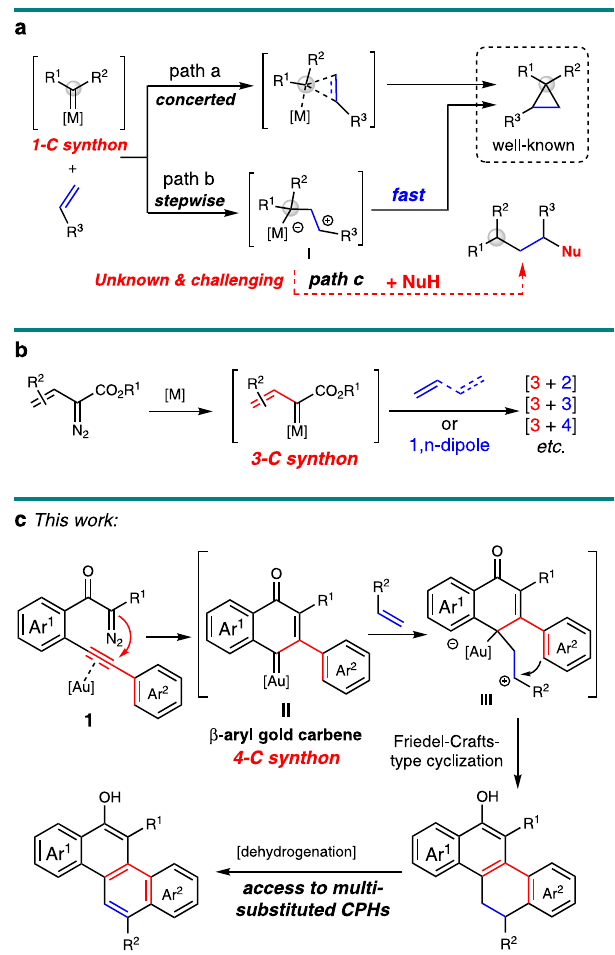
Fig. 1 Catalytic metal carbene cycloadditions. a Concerted and stepwise cyclopropanation. b [3 + n ]-Cycloadditions of vinyl/enol metal carbenes. c This work: gold(I)-catalyzed 6- endo-dig carbocyclization and stepwise [4 + 2] cycloaddition